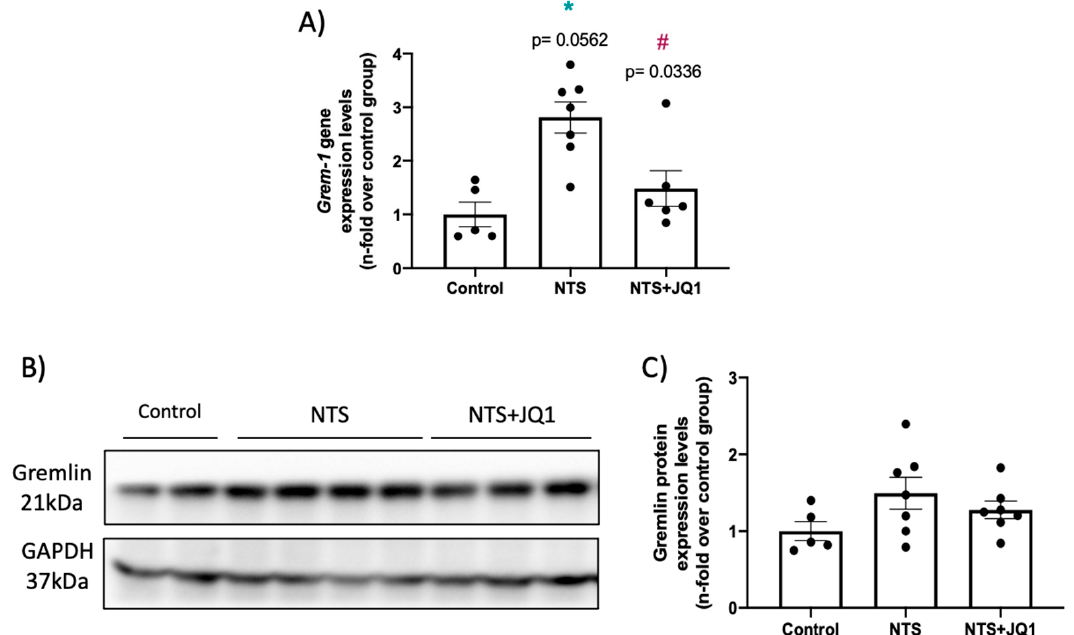
Figure 2. JQ1 diminishes renal Gremlin-1 overexpression at the gene and protein levels in nephrotoxic nephritis. NTS mice were treated daily with JQ1 (100 mg/kg body weight per day) or vehicle. ( A ) RNA was isolated from frozen whole kidney samples, and Grem-1 gene expression lev- els were evaluated by real-time qPCR. ( B ) Protein levels of Gremlin-1 were quantified by Western blot in total kidney extracts. Figure B show a representative blot of 2 to 4 mice per group. GAPDH was used as loading control. ( C ) Quantification of Gremlin protein levels. Data are expressed as the mean ± SEM of 5–7 animals per group. * p < 0.05 vs. control; # p < 0.05 vs. NTS-injected mice.